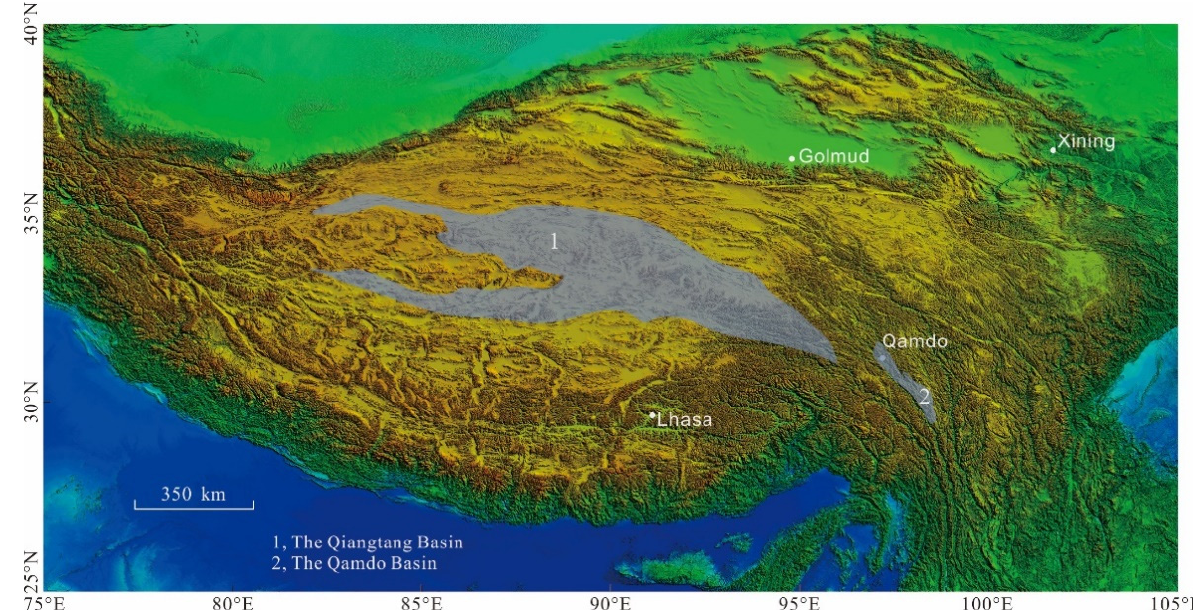
Figure 1. The distribution of Qiangtang and Qamdo Basins (modified from [19]). As the counterpart to the Middle Jurassic Dongdaqiao Formation in the Qamdo Basin, the Middle Jurassic sedimentary sequences in the Qiangtang Basin consist of the Quemocuo, Buqu, and Xiali Formations. The Quemocuo Formation consists of sandstone and mudstone with horizontal bedding, parallel bedding, and cross-bedding. The Buqu Formation was mainly composed of carbonates with horizontal bedding. The Xiali Formation is mainly composed of sandstone, siltstone, and mudstone intercalated with carbonates, muddy carbonates, and anhydrite layers (Figure 3) [20,21]. The anhydrite layers mainly occur in the Xili Formation and subordinately in the Quemocuo and Buqu